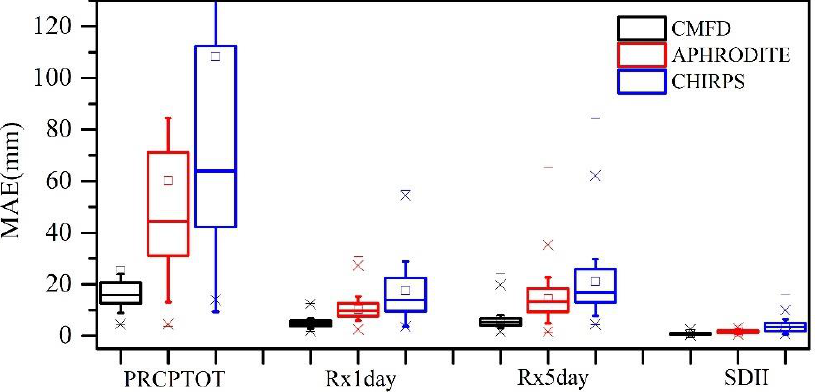
Figure 16. Boxplots of the mean absolute error (MAE) for gauge-based non-threshold indices PRCPTOT, Rx1day, Rx5day, and SDII, as derived from CMFD, APHRODITE, and CHIRPS at 101 rain gauges. Five lines from bottom to top for one box represent minimum value, 25th percentile, 50th percentile, 75th percentile, and maximum value, respectively. The quadrate inside the box represents the mean values. The asterisks represent several possible alternative values.